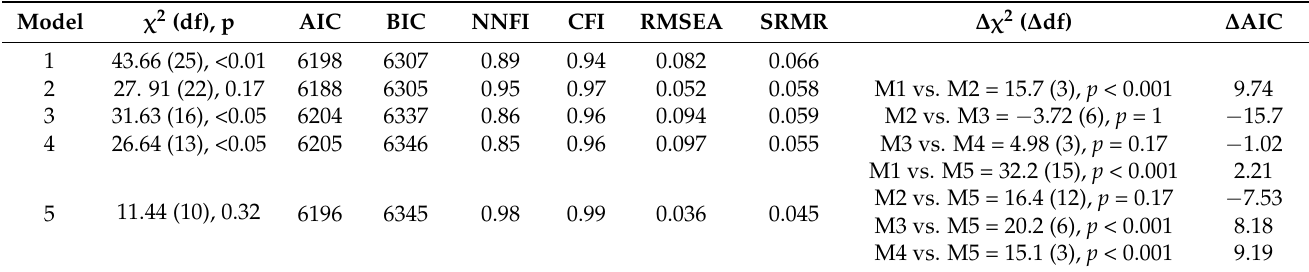
Table 3. Model fit